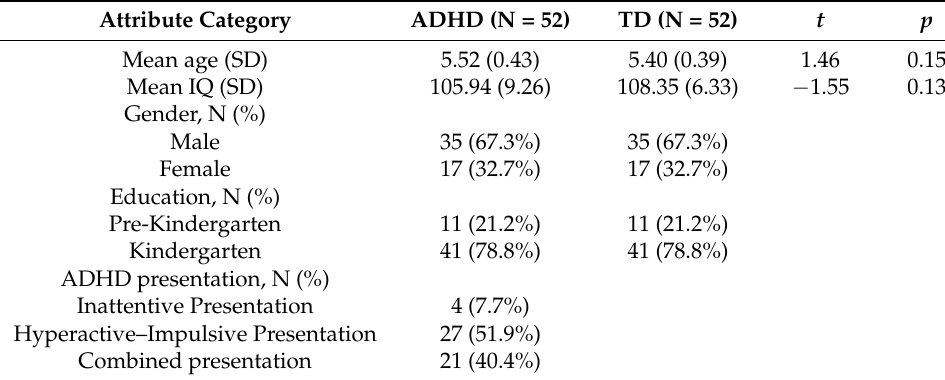
Table 1. Demographic characteristics of